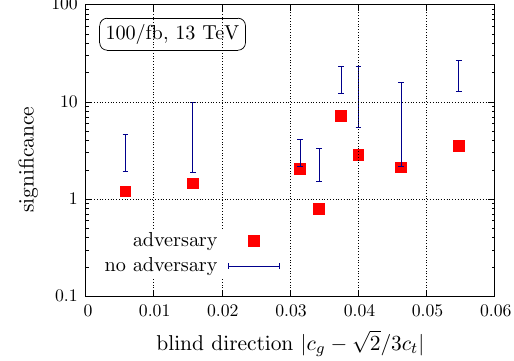
Fig. 6 Performance comparison of the (A)NN using Higgs+multijet final states. For details see text rapidity of the p T -leading and second-leading jet, azimuthal angle between the jets and rapidity and invariant mass of the jet pair. As the uncertainties become limiting factors in par- ticular in the vicinity of the blind direction c g − express the final score as a function of the deviation away √ 2 c t / from c g =